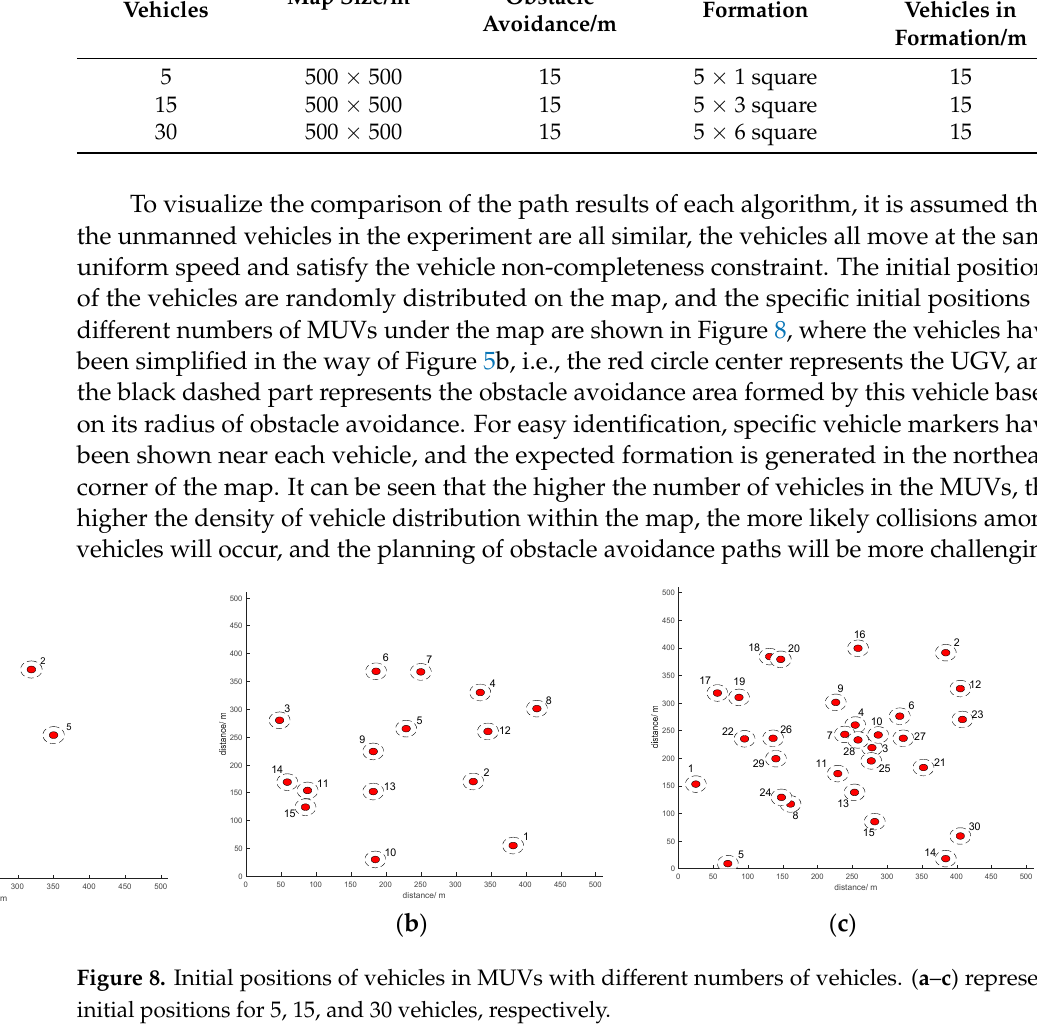
( c ) Figure 9. The path results of each algorithm for vehicle No. 1 with 5 vehicles in MUVs. ( a ) is the path result of RRT-connect; ( b ) is the path result of RRT*; ( c ) is the path result of dual RRT optimization.